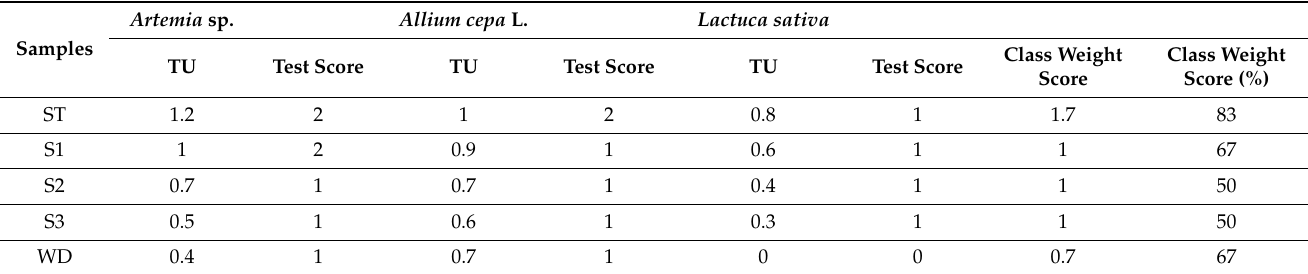
Table 3. Results of Toxic Unit (TU) and Class Weight Score. Artemia Samples